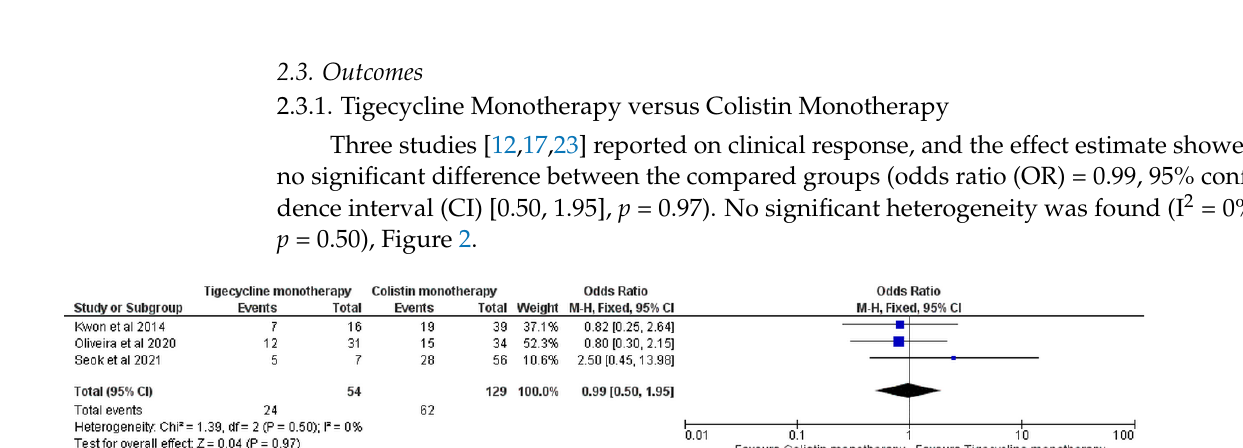
Figure 2. Clinical response of tigecycline monotherapy versus colistin monotherapy [12,17,23].